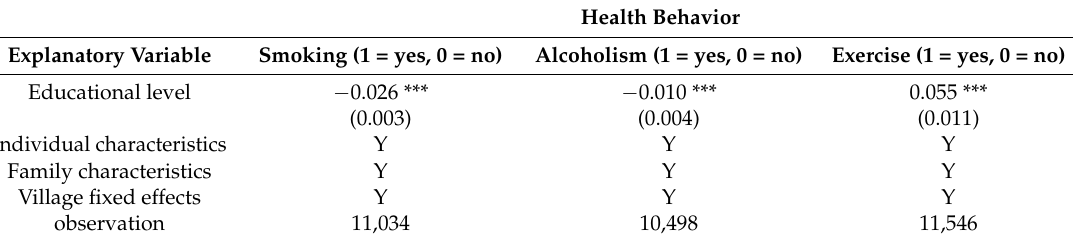
Table 7. The impact of education on health behavior